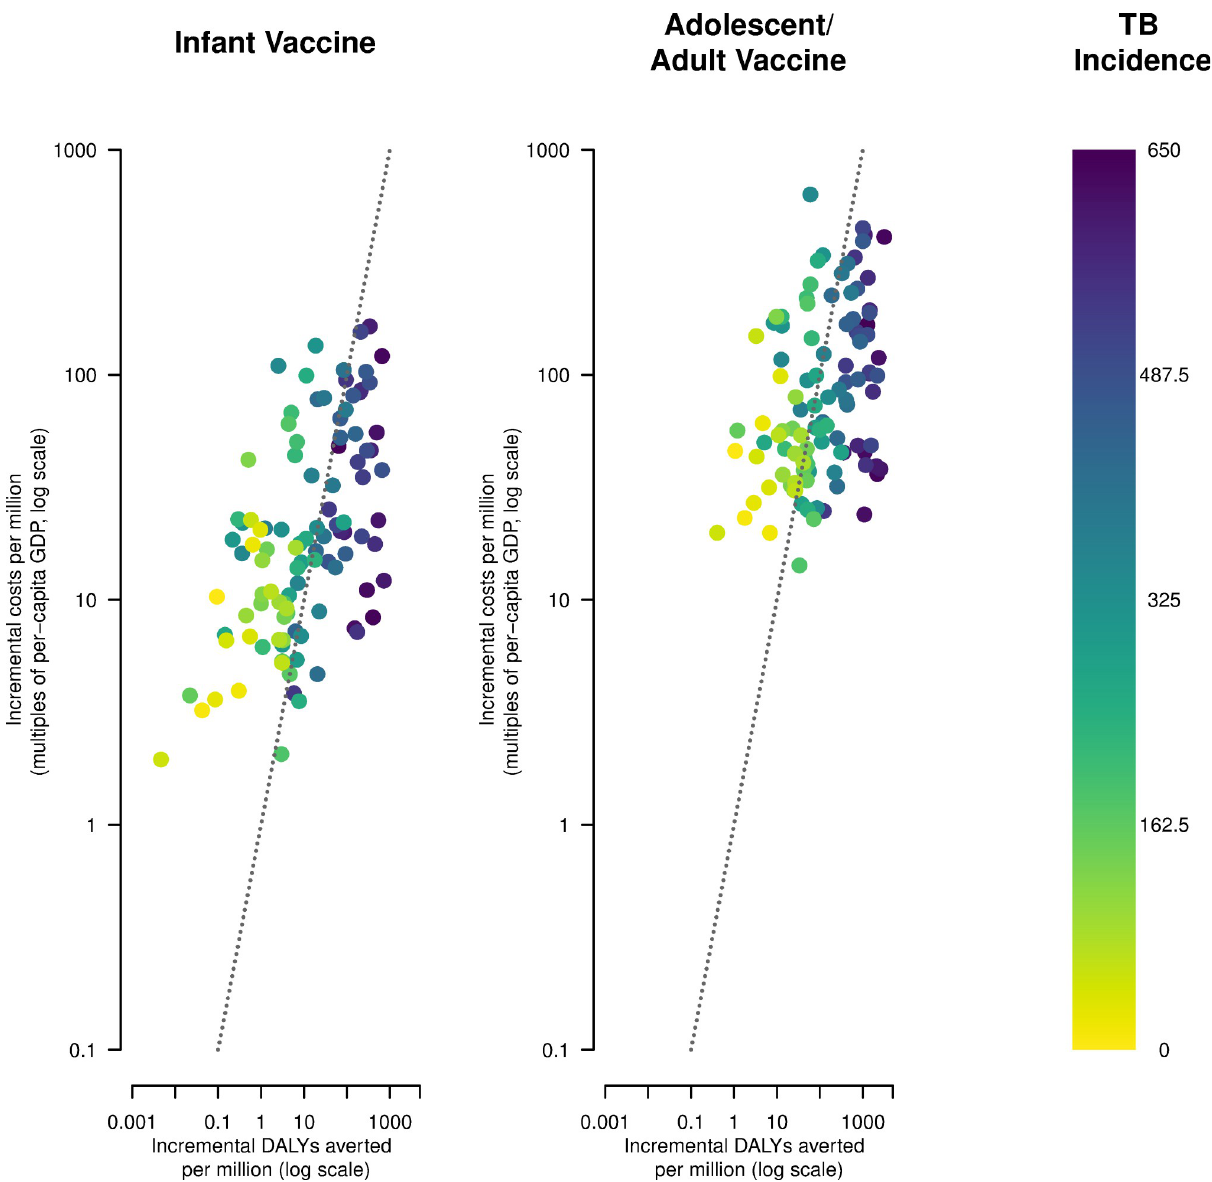
Fig 1. Cost-effectiveness results from the health system perspective for novel tuberculosis vaccines by country and vaccine. Note: Points represent each of 105 LMICs analyzed in the base-case scenario, stratified by TB incidence per 100,000. Line represents a cost-effectiveness threshold of 1 × per- capita GDP in 2020. Vaccine introduction would be considered cost-effective for countries falling underneath this line. DALY, disability-adjusted life year; GDP, gross domestic product; LMIC, low- and middle-income country; TB, tuberculosis.